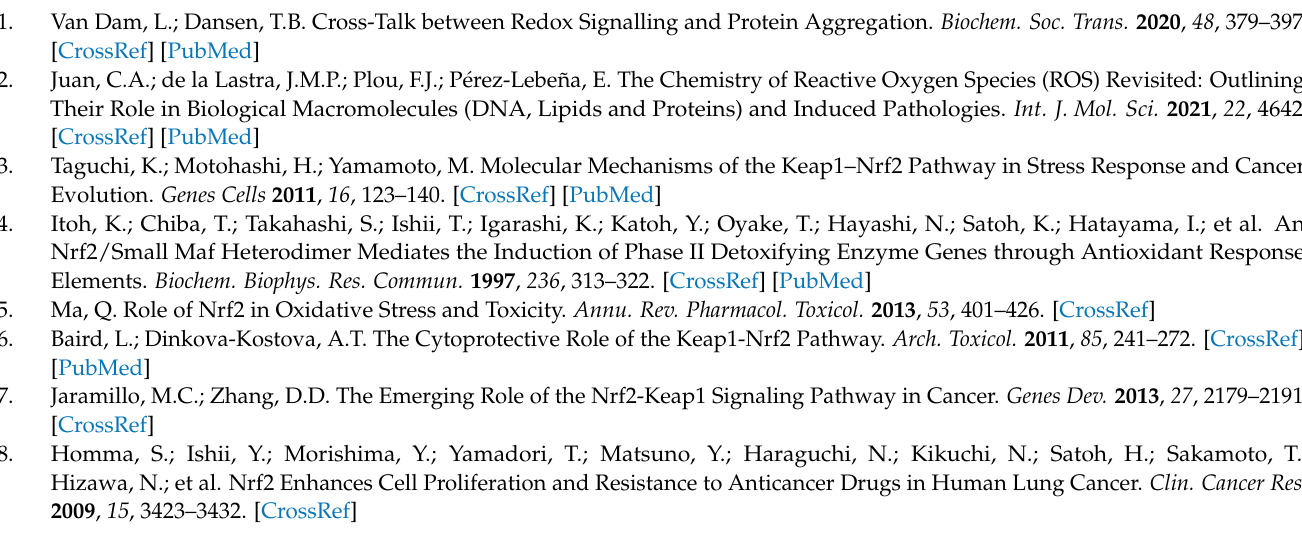
Figure S2: Bioinformatics predictions of the structural properties of FL-Nrf2, Figure S3: 1 H- 15 N HSQC spectrum of FL-Nrf2 recorded at 35 ◦ C in the presence of 6 M urea, Figure S4: The CD spectrum of Neh1–2LZ1 recorded at 20 ◦ C, Figure S5: Peptide coverage of FL-Nrf2 and Kelch domain of Keap1, Figure S6: HDX data suggest the majority of FL-Nrf2 is not protected, Figure S7: The (A) SSD-AGE and (B) SDS-PAGE results of the sedimentation assay show that the FL-Nrf2 does not form aggregates at low concentrations, Table S1: Estimated secondary structural contents presence in FL-Nrf2 at different temperatures, The procedure of the sedimentation